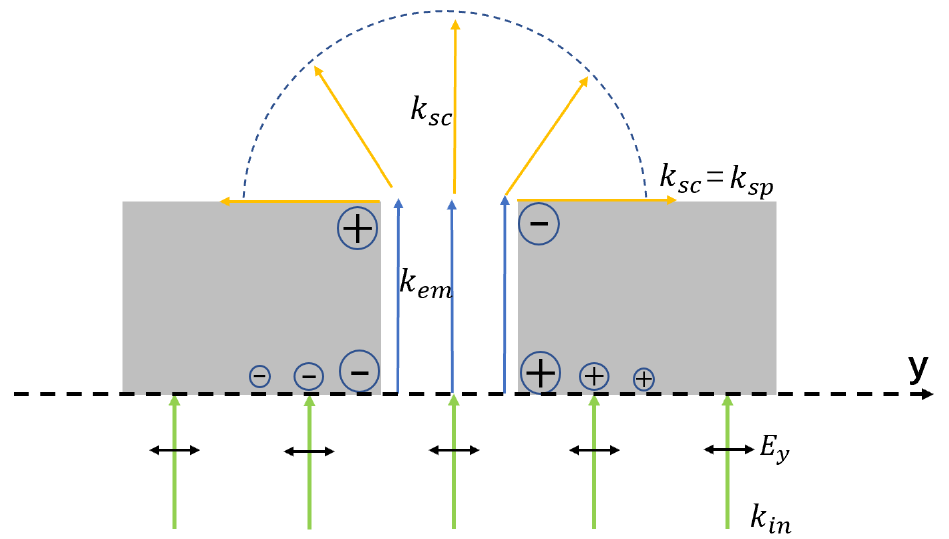
Figure 1. Schematic diagram of SPPs excited by the metal slit.